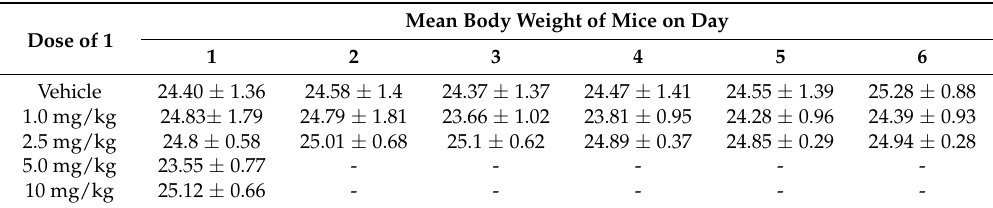
Table 1. Mean body weights of the mice injected i.p. with different doses of prosopilosidine (PPD). All values are expressed as mean ± SD ( n = 5).